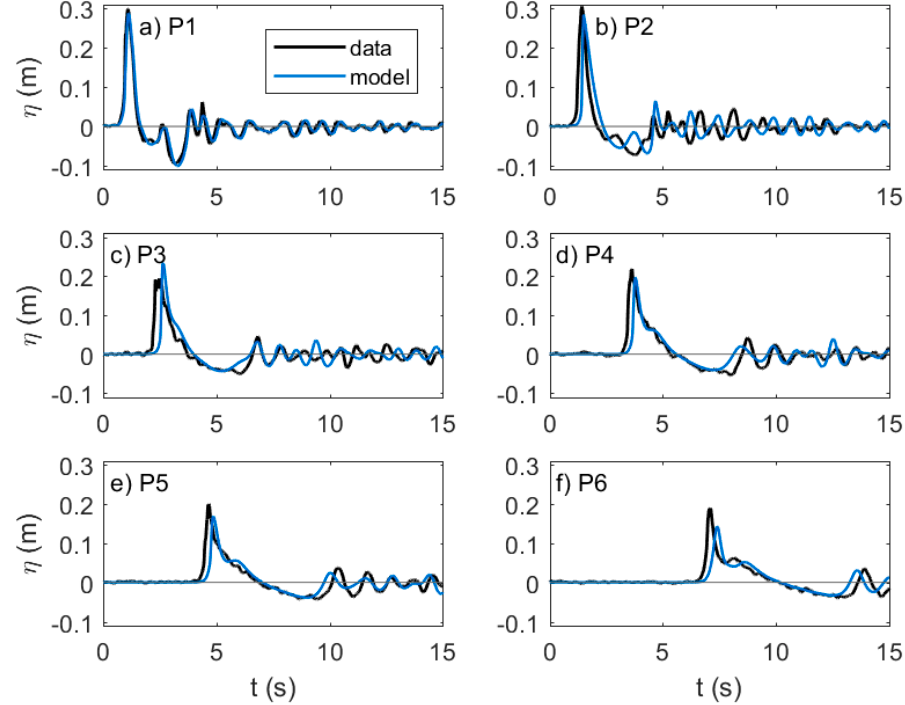
Figure 6. Water surface elevation time series for the high landside mobility case from experimental observations and numerical simulation. Time t = 0 s is referenced to the slide impact time. Wave probe sites shown in Figure 1 are: ( a ) P1; ( b ) P2; ( c ) P3; ( d ) P4; ( e ) P5; and ( f ) P6.